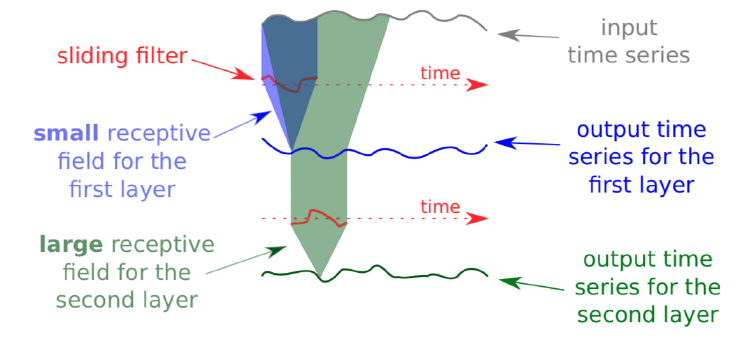
Figure 6: Receptive field representation from a two-layers CNN. Taken from [FLF +